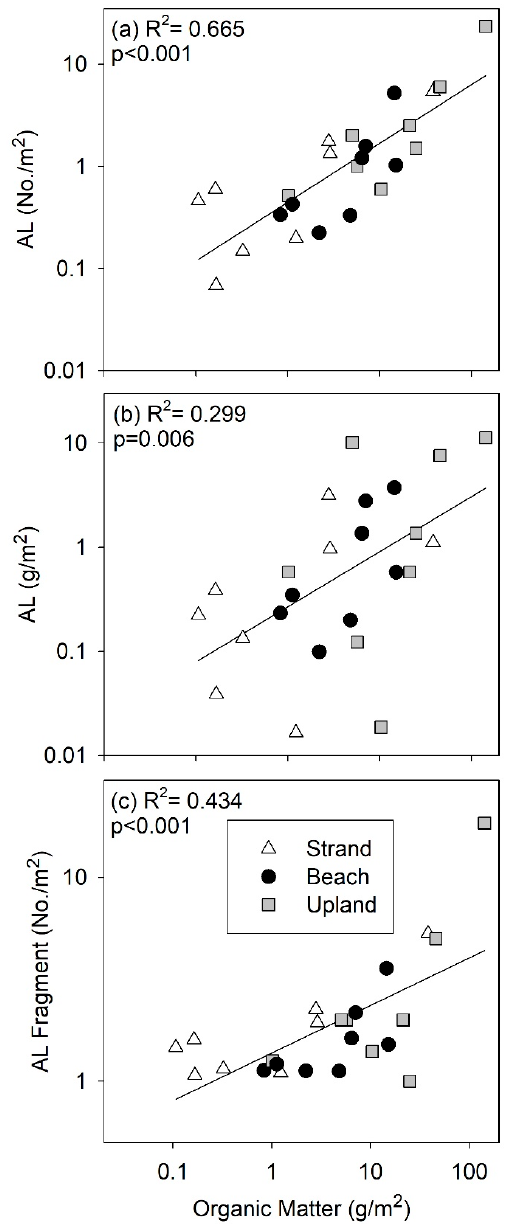
Figure 5. Simple linear regression between organic matter standing stock and ( a ) anthropogenic litter (AL) density by number, ( b ) AL density by mass, and ( c ) AL fragment density by number.